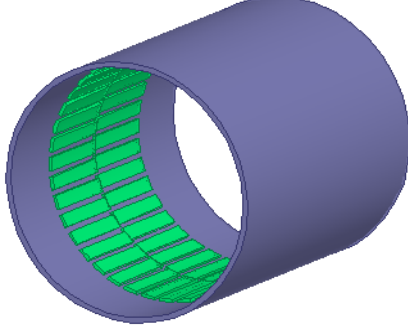
Figure 26. Diagram of the outer rotor.